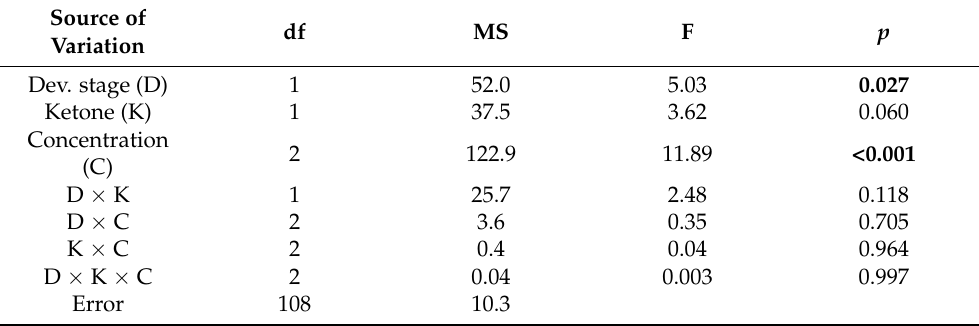
Table 5. Mean squares (MS), F and p values obtained from three-way ANOVA testing of the significance of the main (D—developmental stage, K—camphor or thujone-camphor mixture, C—concentration) and the interaction effects on choice time in an olfactometer. Significant effects are marked in